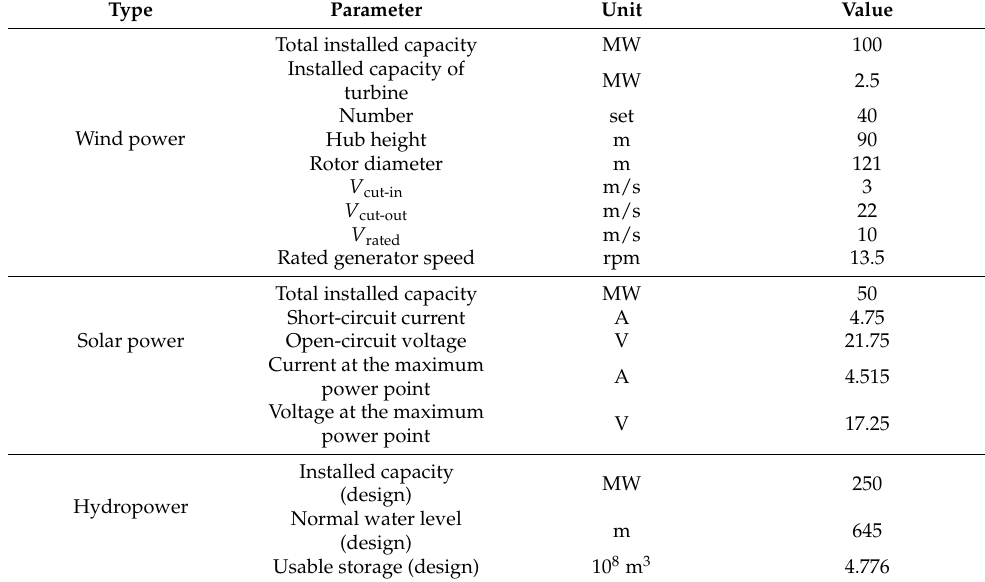
Table 2. Parameters of HRES model in the